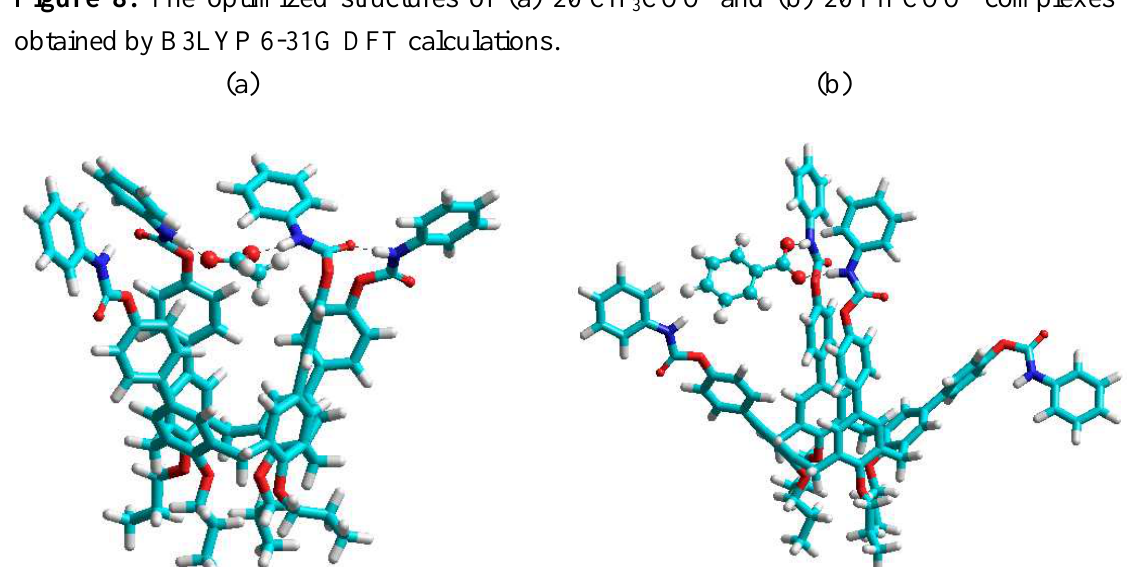
COO - and (b) 20 (cid:215) Ph-COO - complexes 3